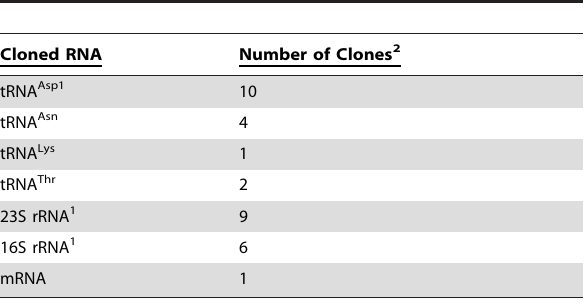
Table 1. Sequence analysis of cloned extracellular mycobacterial RNA fragments present in M. tuberculosis CF.